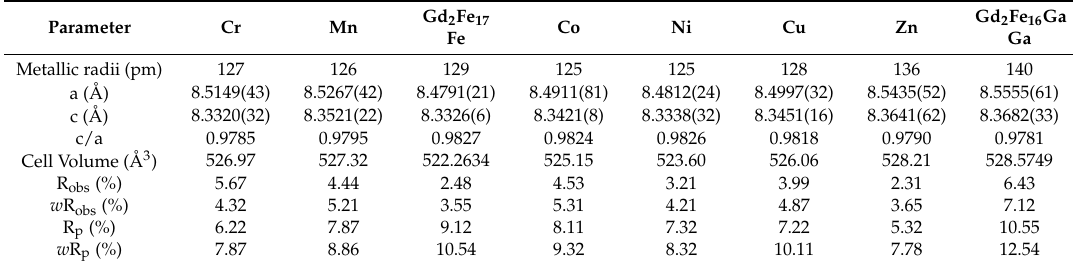
Table 1. Structural parameters derived from Rietveld refinement of powder XRD data of Gd 2 Fe 17